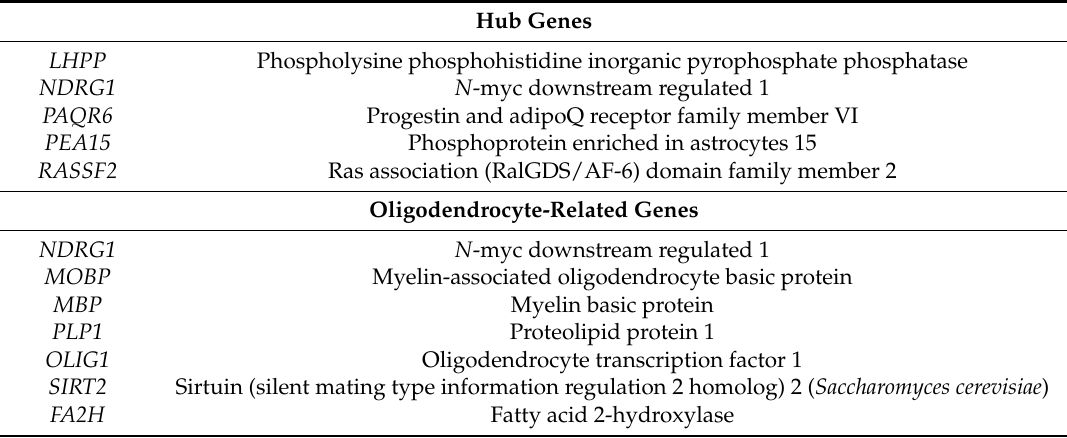
Table 1. Hub genes and oligodendrocyte-related genes that co-downregulate in spinal cord periplaques as compared to NAWM.